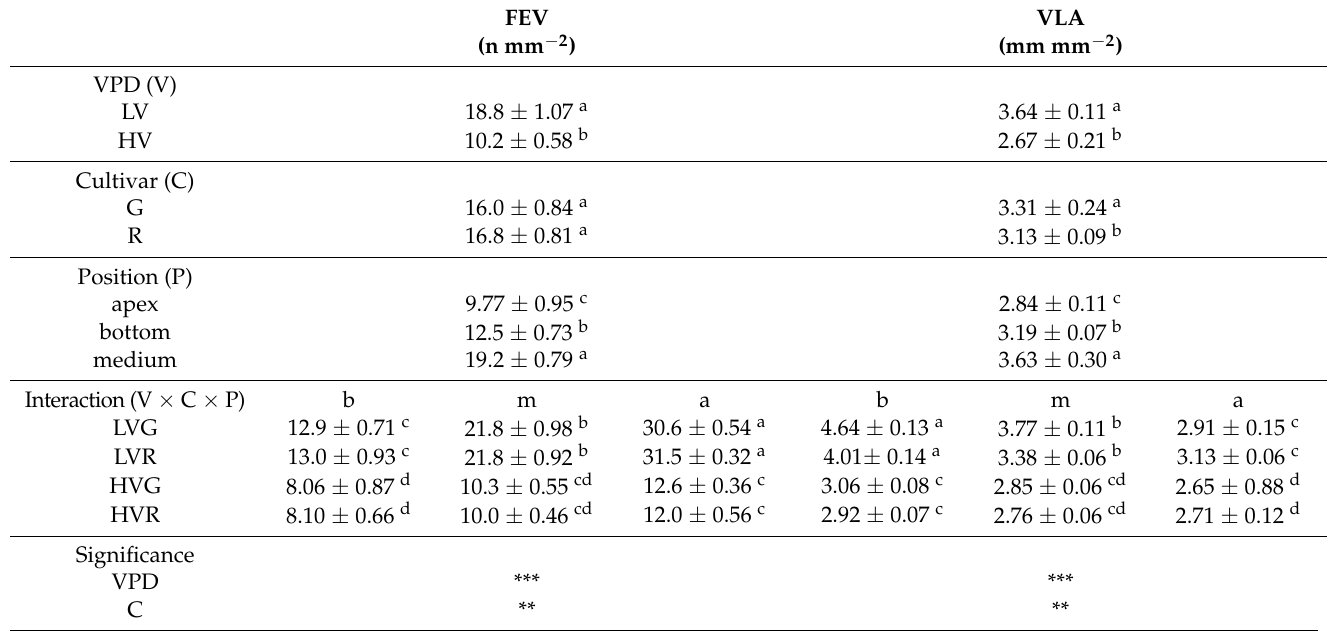
Table 4. Vein traits in terms of free vein endings (FEV) and vein density (VLA) from green (G) and red (R) Salanova plants grown under low (LV) and high (HV) VPD with differences within the leaf parts: b, bottom; m, medium; a, apex. All data are reported as mean ± se. Different letters indicate significant differences, according to Tukey test ( p <